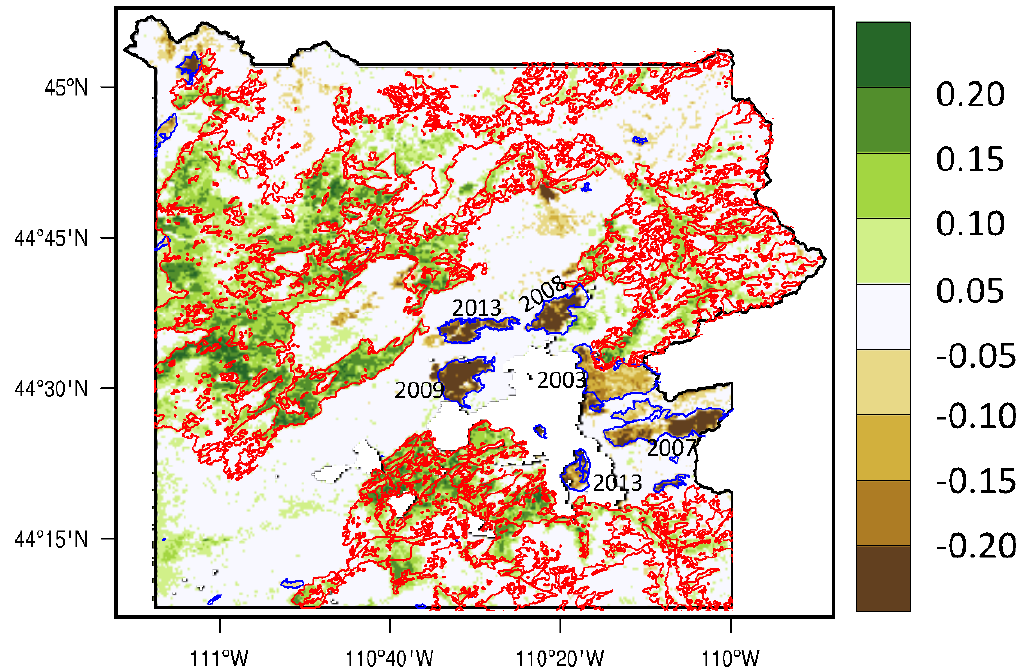
Figure 10. Change (shading) in Moderate Resolution Imaging Spectroradiometer (MODIS) Normalized Difference Vegetation Index (NDVI)-based productivity for May–September of 2001–2016, based on linear trend from the Theil–Sen slope estimator, with overlying red polygons indicating the spatial extent of the 1988 widespread fires and overlying blue polygons indicating the extent of the 2003, 2007, 2008, 2009, and 2013 localized fires according to fire perimeter data from the Yellowstone National Park Spatial Analysis Center. The negative NDVI trends in proximity to Yellowstone Lake are associated with fires in 2003, 2007, 2008, 2009, and 2013, as labeled.